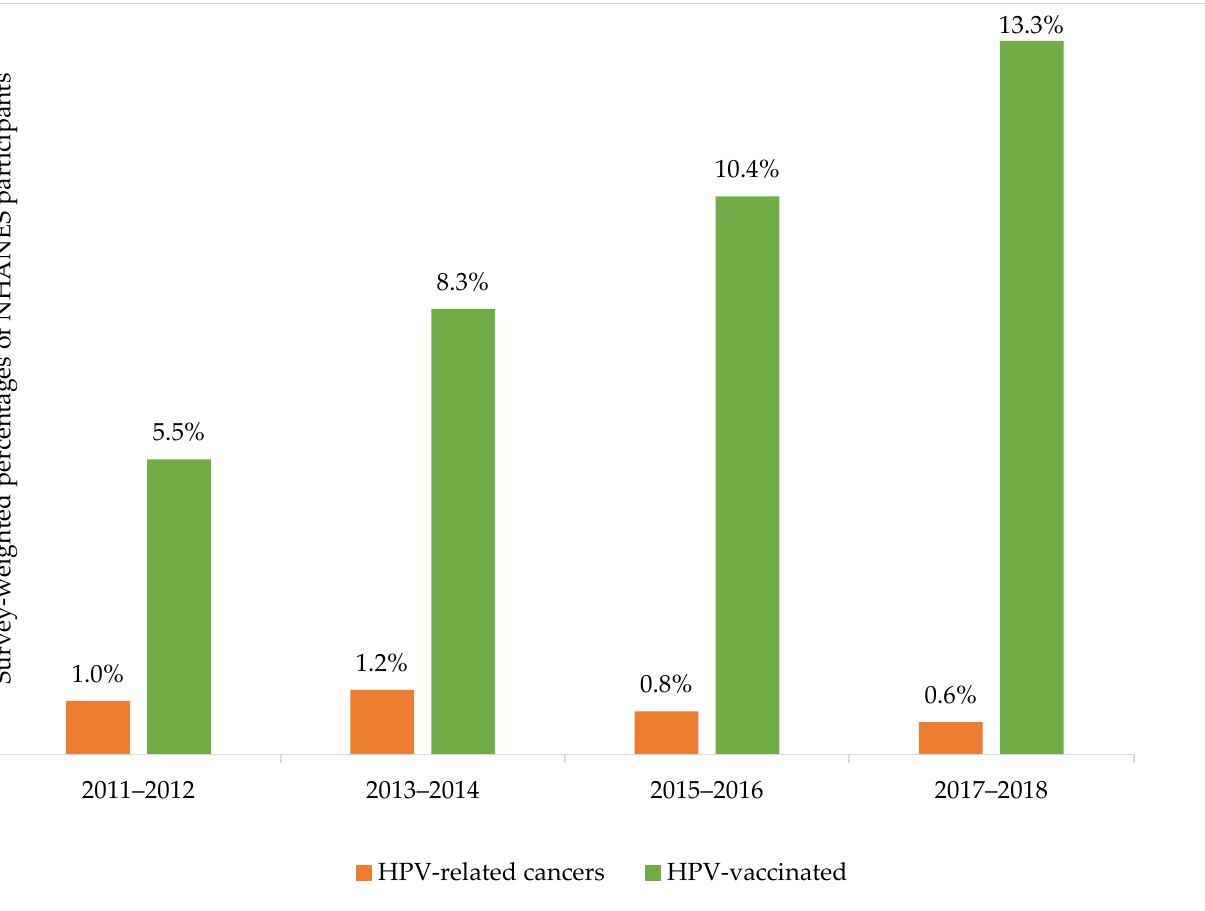
Figure 3. Prevalence of head, neck and genital cancers, prevalence of cervical cancer and HPV vaccination prevalence, stratified by the National Health and Nutrition Examination Survey (NHANES) cycles between 2011 through 2018.